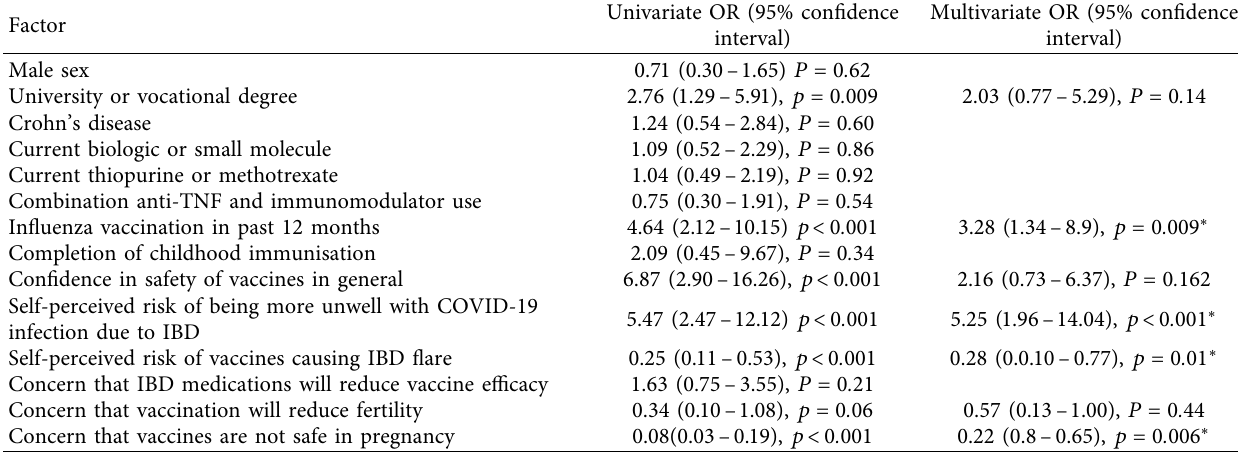
Table 2: Factors associated with vaccine uptake.